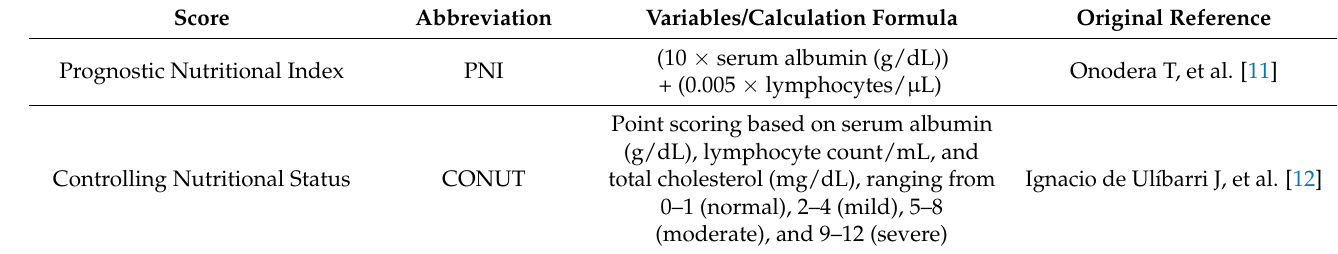
Table 1. Scores and indexes utilized in the